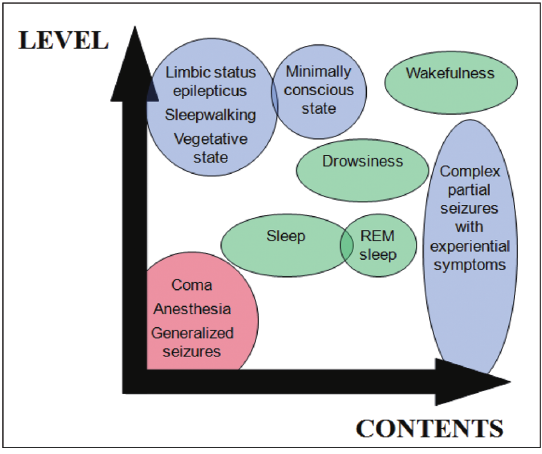
Fig.1. Simplified representation ofconsciousness asabidimensional model, along the two axes of Level (Y) and Contents (X). Normal physiological states (green) show positive correlation between level and content of consciousness, with the exception of the dream state in REM sleep. Abnormal states (red) such as coma, anaesthesia and generalised seizures represent a loss of consciousness where both arousal and awareness is low or absent. Dissociated states of con- sciousness (blue) include vegetative state, sleepwalking and limbic status epilepticus, in which the individual exhibits a high level of arousal but a low awareness of themselves and their surroundings. Minimally conscious state (MCS) is differentiated from vegetative state as individuals in MCS can demonstrate limited levels of aware- ness. Complex partial seizures with experiential symptoms involve a variable level of arousal, while the contents of consciousness are highly vivid, characterized by seizure-induced experiential phenom-